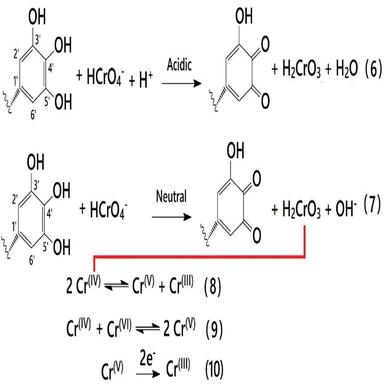
Proposed reaction pathways for Cr(VI) reduction by EGCG (,).